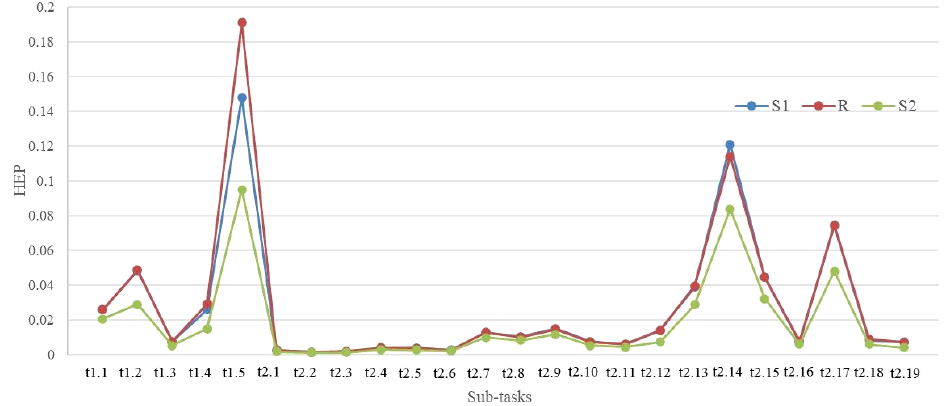
Figure 2. The HEP results of S1, S2, and reference data.